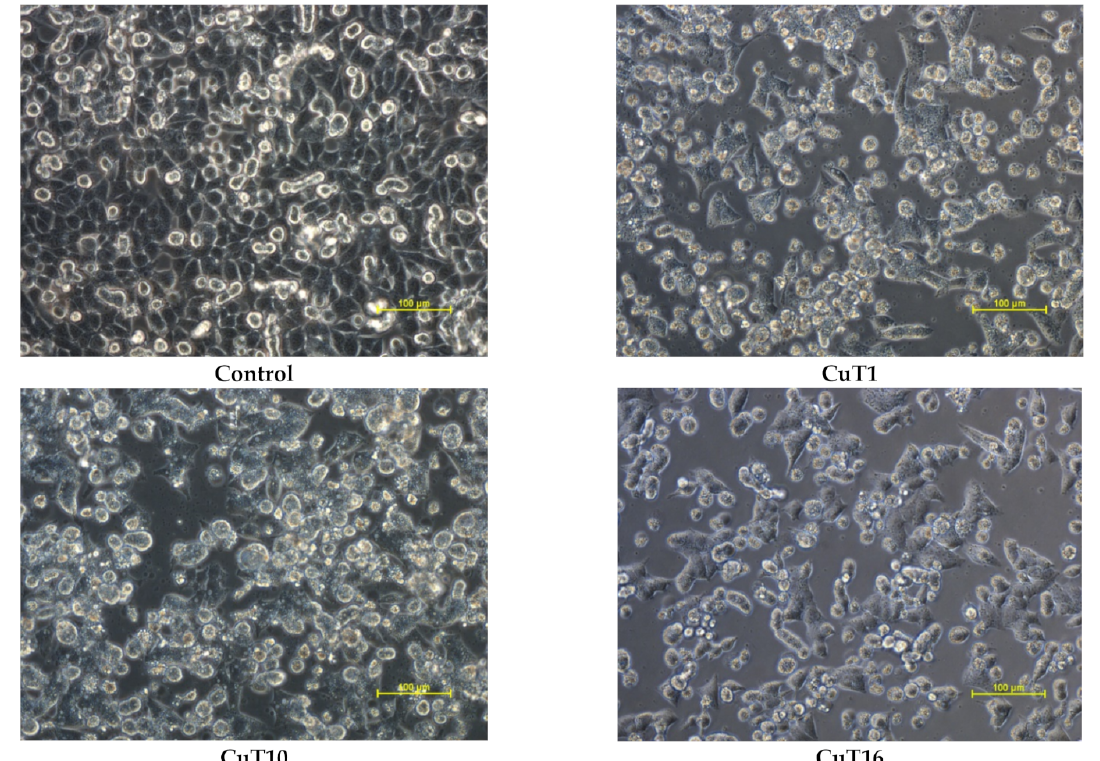
Figure 5. Morphology of A375 cells treated with CuT1, CuT10, and CuT16 compound in concentration corresponding to appropriate IC 50 value (69.92, 26.05, and 144.60 µ M, respectively) or DMSO as vehicle in control